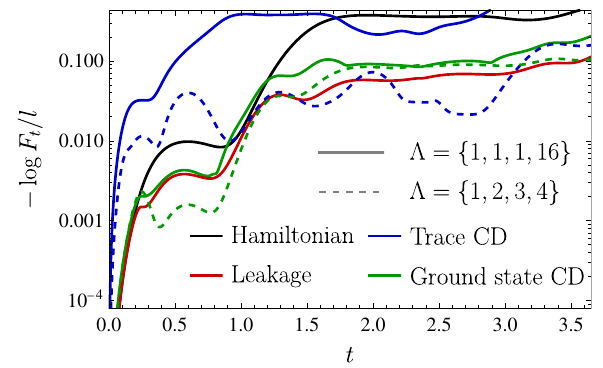
FIG. 9. The logarithm of the fidelity for the Hamiltonian TLFIM dynamics (black) and the three optimization approaches (colored). For the CD approaches, the solid lines correspond to a choice of free parameters (cid:25) = { 1, 1, 1, 16 } , while the dashed lines correspond to (cid:25) = { 1, 2, 3, 4 } . We observe that there is con- siderable difference between the two choices, and, in line with expectations, the leakage approach outperforms CD approaches at early